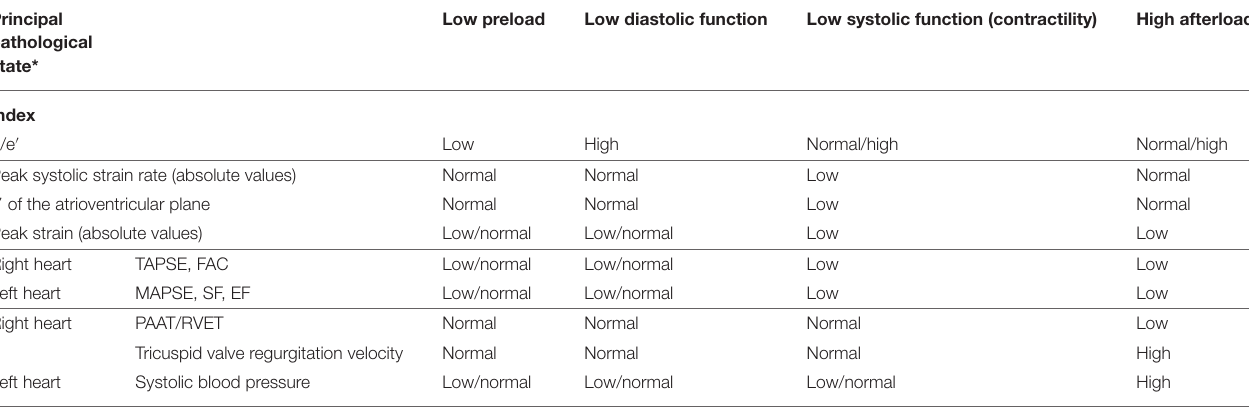
TABLE 1 | Expected changes in neonates with circulatory